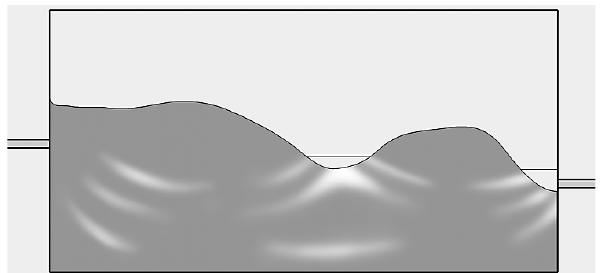
Fig. 5. A tracer experiment with schematically drawn tracer clouds (flow lines) from tracer injections at different depths performed at different times or different locations. Fig. 6. Tank with fine sand (yellow colour) and coarse sand (brown)